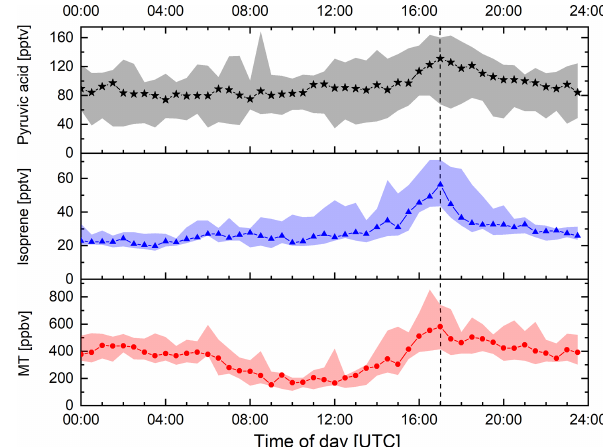
Figure 3. Diel profiles of median mixing ratios of pyruvic acid, iso- prene and monoterpenes (MT) during the IBAIRN campaign. The shaded area represents the 25th and 75th